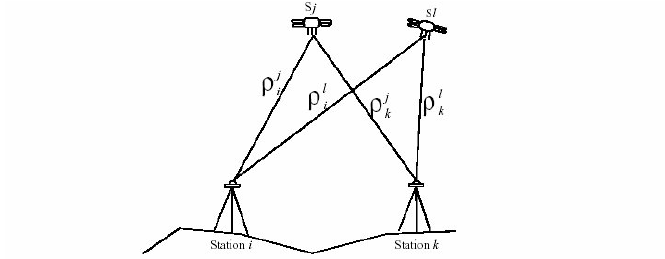
Figure 2: The double-difference geometry